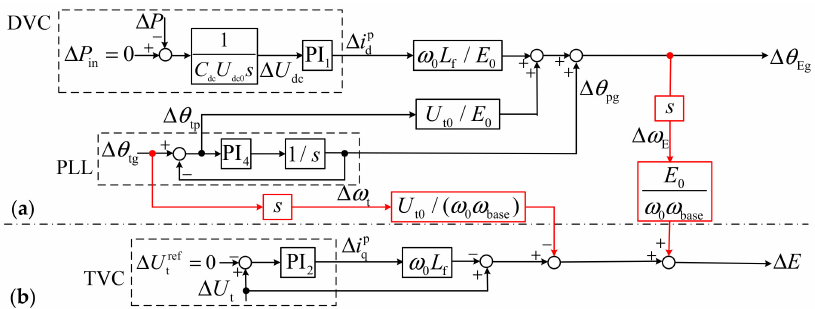
Figure 7. The small-signal model of VSC’s internal voltage in DVC timescale. ( a ) Phase dynamics of VSC’s internal voltage. ( b ) Amplitude dynamics of VSC’s internal voltage.